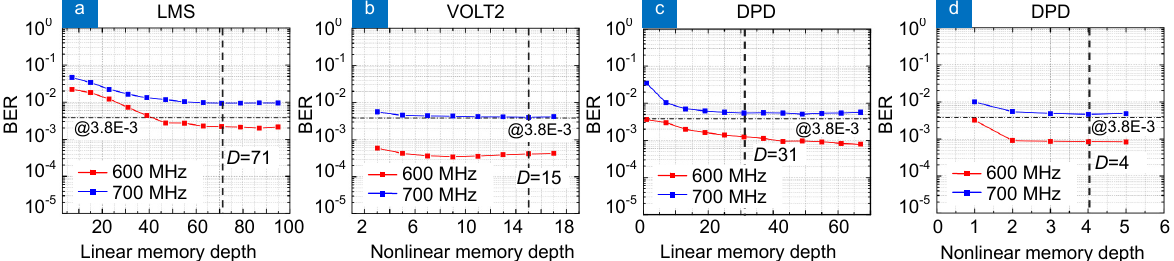
Fig. 5 | BER performance when using ( a ) LMS linear equalizer under different numbers of linear memory depth; ( b ) VOLT2 nonlinear equalizer under different numbers of nonlinear memory depth and fixed number of linear memory depth (71); ( c ) DPD under different numbers of linear memory depth and fixed number of nonlinear memory depth (4); ( d ) DPD when using different numbers of nonlinear memory depth and fixed number of linear memory depth (31). All the measurements are taken when the bandwidth of CAP-16-QAM is 600 MHz and 700 MHz. D : the optimal and utilized memory